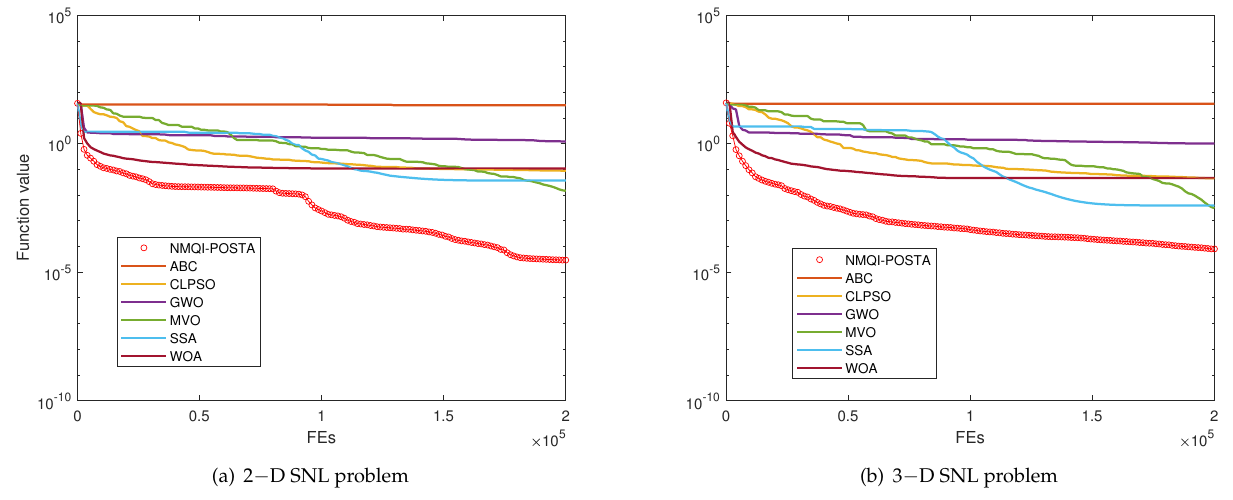
Figure 9. Average convergence curves of different metaheuristic methods in the SNL